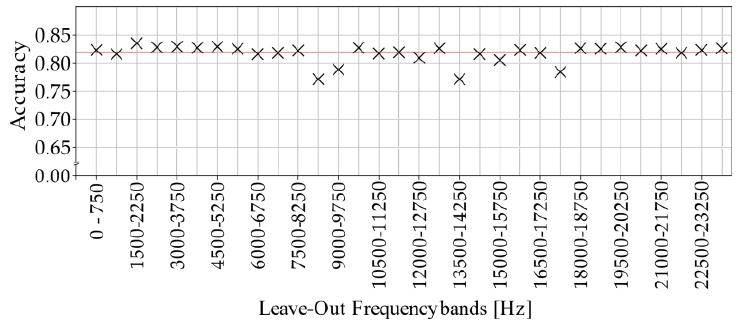
Figure 12. Prediction accuracies over Leave-Out frequency bands with a bandwidth of 750 Hz. At three frequency bands the accuracy drops significantly. This indicates that the model did not have enough features. This leads to the conclusion that the skipped bands are relevant features. Those features are located at higher frequencies. Furthermore, leaving out certain frequency bands does not lead to better prediction results, i.e., the left-out band did not contain misleading information.